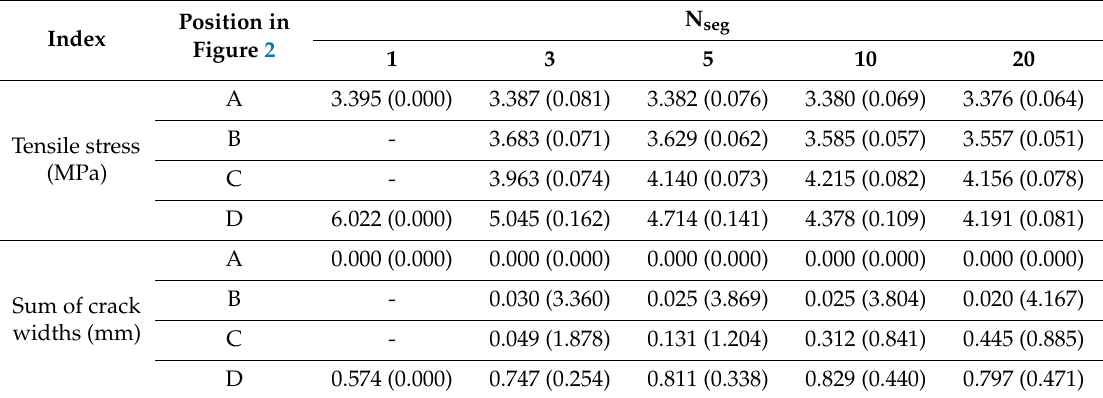
Table 1. Predictions on the tensile stresses and corresponding sum of crack widths.